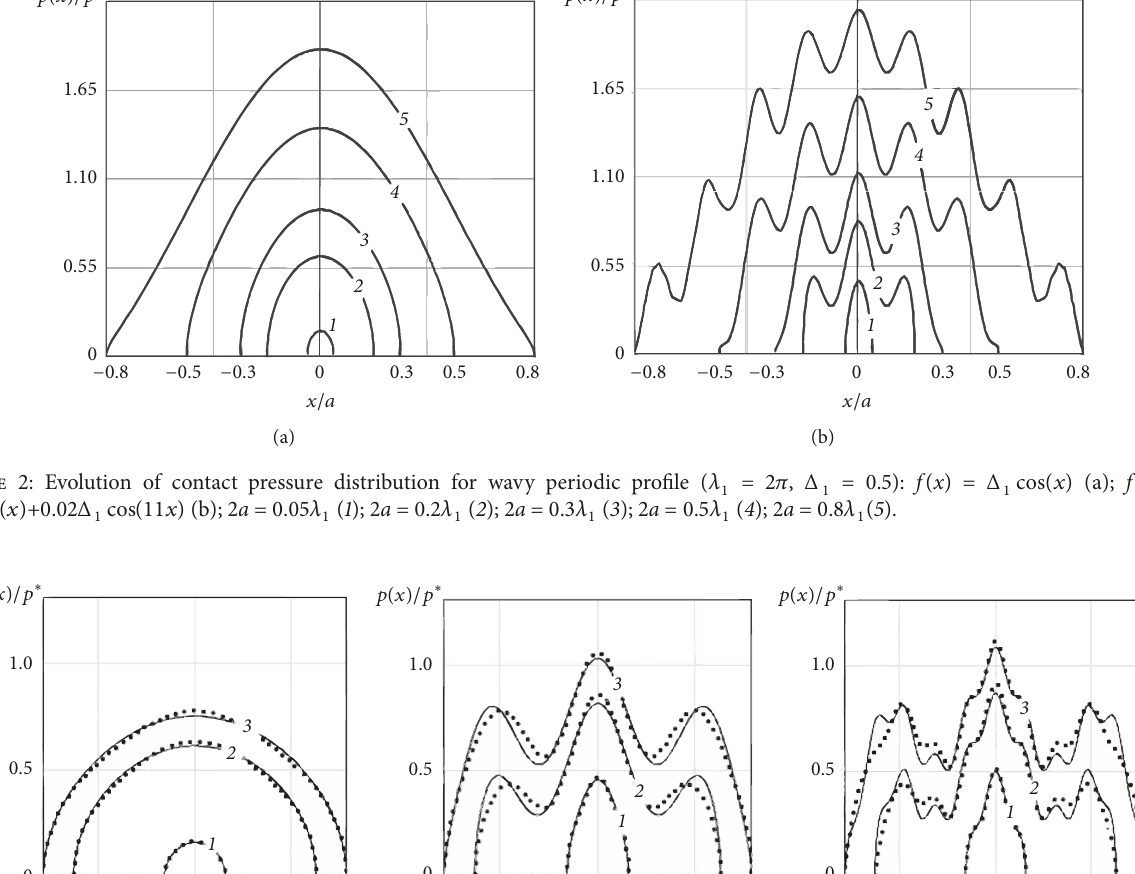
(𝑥) +0.02 Δ (11𝑥) +0.0015 Δ (40𝑥) (c); 2 a = 0.05 𝜆 1 cos 1 cos 1 cos